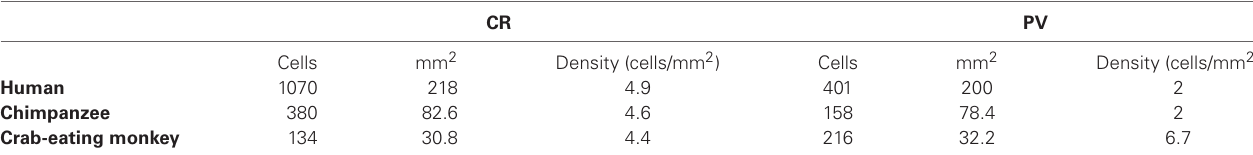
Table 1 | Distribution and density pattern of CR-, PV-, SOM- and NPY-ir cells in the dorsal, central and ventral regions of the claustrum . Human Chimpanzee Crab-eating macaque Dorsal Central Ventral Dorsal Central Ventral Dorsal Central Ventral CR + + + + ++ + + + + ++ + + + + ++ PV + + + + SOM + + NPY ++